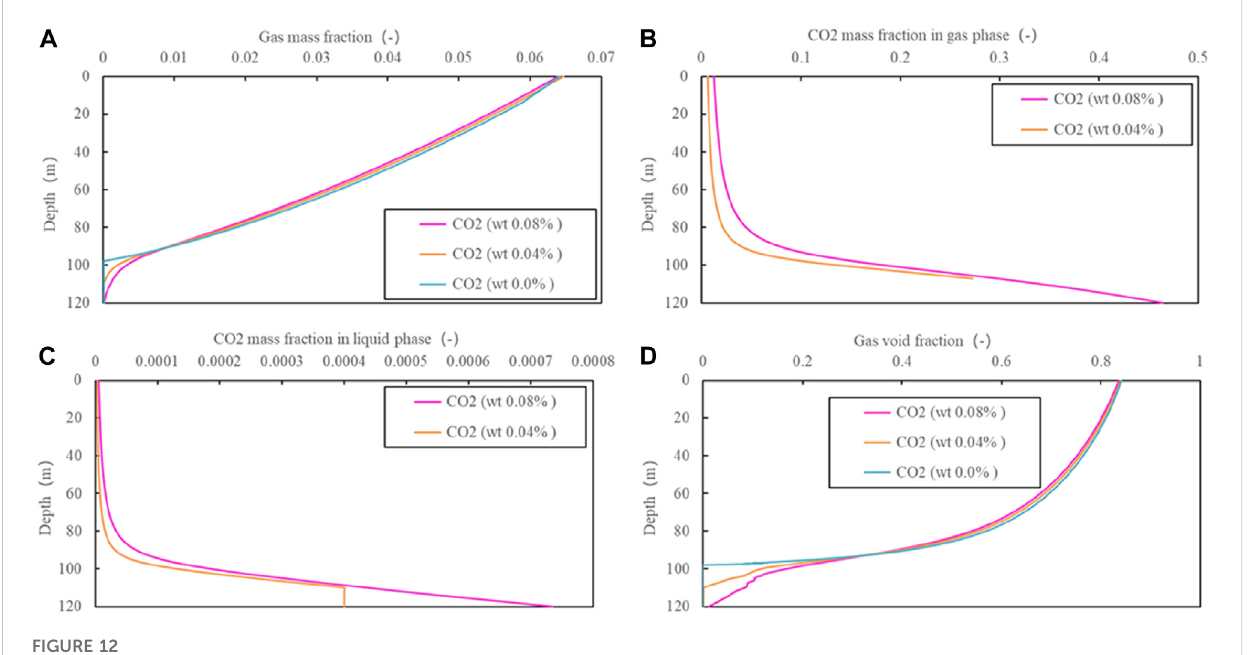
FIGURE 12 Simulated results by Shi et al. model for ZK304.